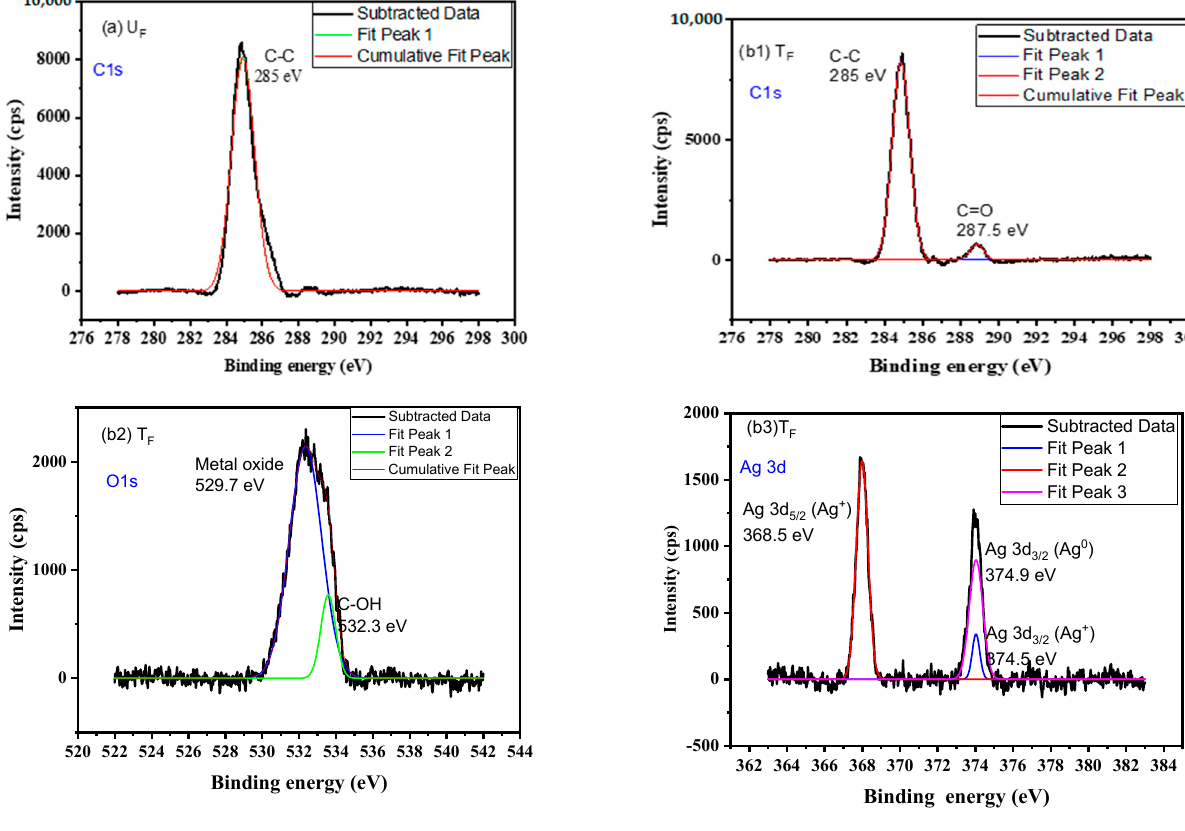
Figure 7. XPS spectra of ( a ) U F for C1s; ( b ) T F with ( b1 ) for C1s, ( b2 ) for O1s, and ( b3 ) for Ag 3d.